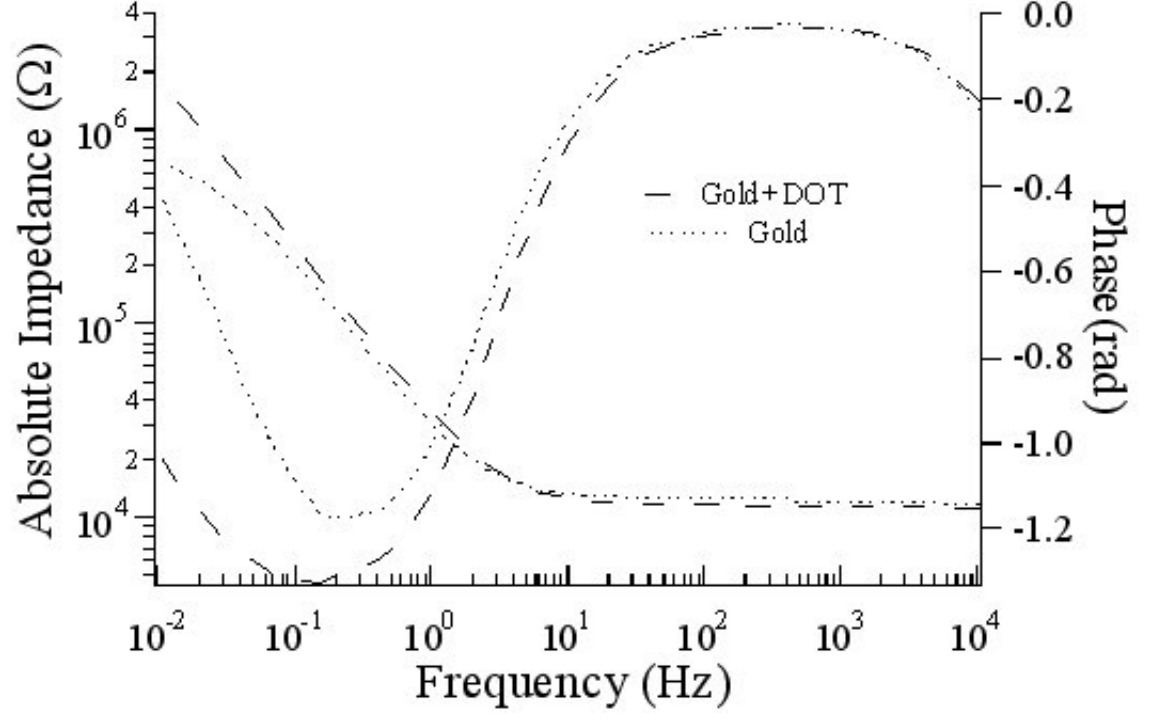
Figure 1a . Impedance spectrum of gold/elecrolyte and gold/DOT/electrolyte interface between 10 -2 and 1 · 10 5 Hz, at a potential of 0V